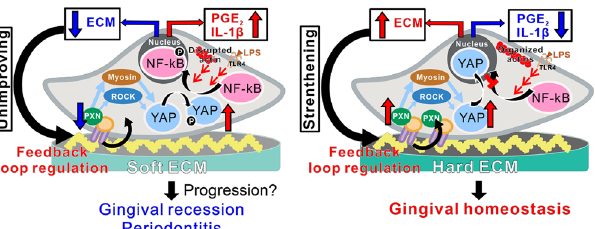
Figure 7. Possible cellular mechanisms underlying substrate stiffness-mediated proinflammatory responses of hGFs. A hypothetical scheme showing the cellular mechanotransduction mechanisms underlying the regulation of proinflammatory responses and ECM production in human gingival fibroblasts by ECM stiffness. The soft ECM inactivates YAP and activates NF-kB in gingival fibroblasts via disruption of focal adhesion formation and cytoskeletal development, even in the absence of LPS stimulation. Inactive YAP cannot stop nuclear translocation of p-NF-kB, leading to the expression of proinflammatory mediators, such as prostaglandin E2 (PGE 2 ) and IL-1 β and suppression of ECM synthesis in gingival fibroblasts particularly under an inflammatory condition. The unimproved ECM structure of the soft ECM continues to regulate the feedback loop of gingival fibroblasts according to these cascades, possibly progressing gingival recession and periodontitis (left). On the other hand, the hard ECM prevents proinflammatory responses and strengthens ECM structure via inactivation of NF-kB by active YAP translocated into nucleus (right). The rigid structure of ECM keeps gingival homeostasis by feedback loop regulation of gingival fibroblasts with physical signals of ECM stiffness (right). hGFs human gingival fibroblasts, ECM extracellular matrix, PXN paxillin, ROCK rho-associated, coiled-coil containing protein kinase, LPS lipopolysaccharide, TLR4 toll-like receptor 4, YAP yes-associated protein, NF-kB